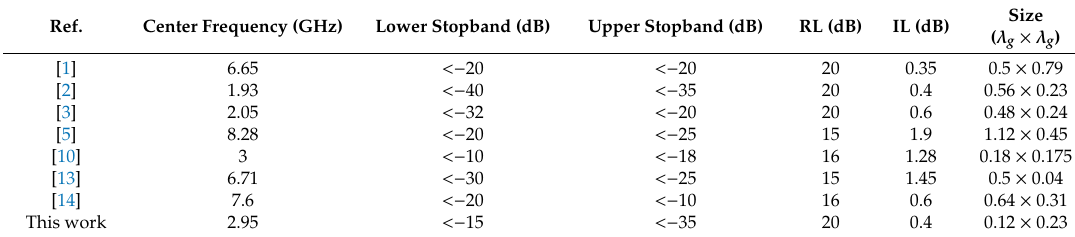
Table 1. Comparisons with Some Previous Bandpass